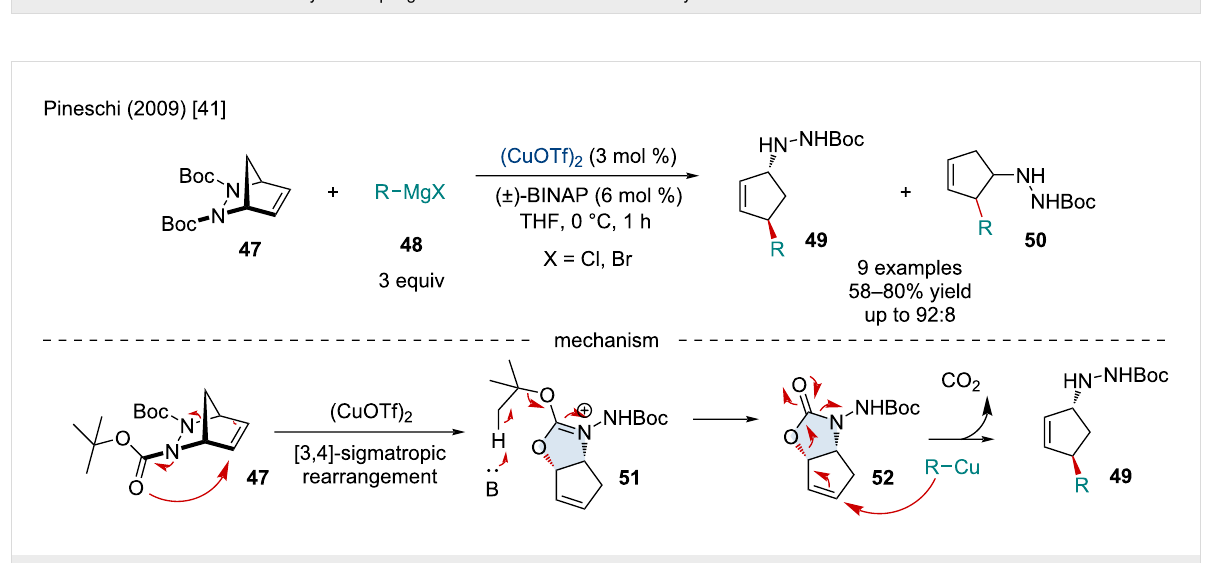
Scheme 7: Photoredox/Ni dual-catalyzed coupling of α -amino radicals with heterobicyclic alkenes 30 .